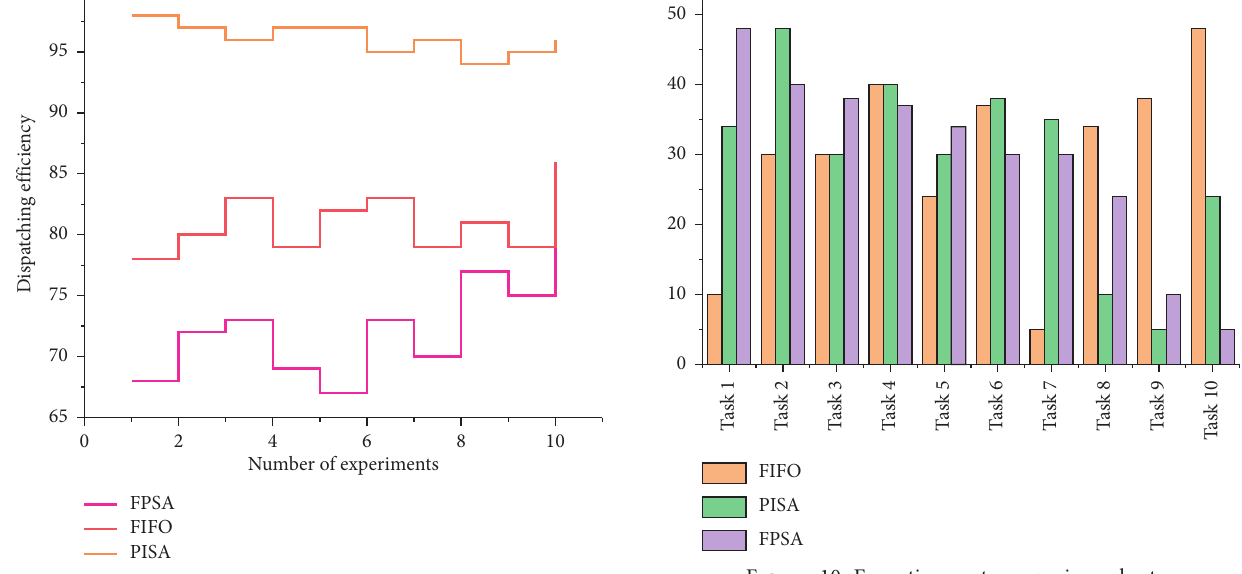
Figure 8: Comparison of scheduling efficiency of different algorithms.